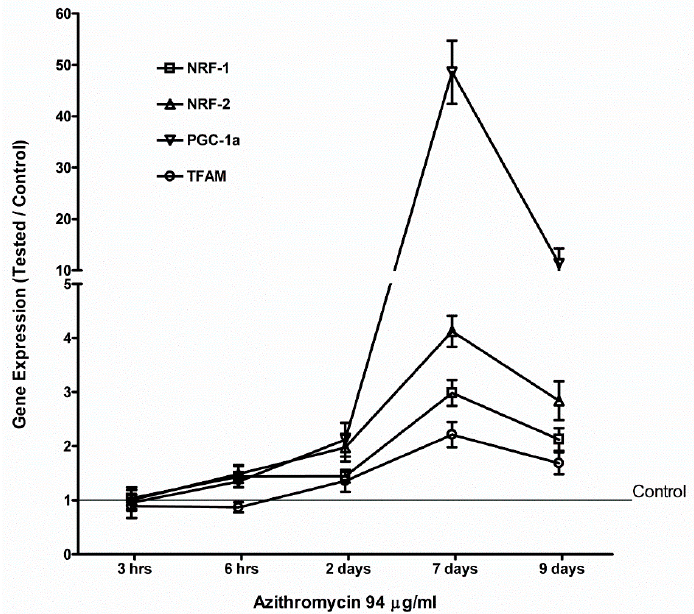
Figure 5. Azithromycin increased gene expression of mitochondrial biogenesis factors in MCF-12A cells. NRF-1 : nuclear respiratory factor 1; NRF-2 : nuclear respiratory factor; PGC-1a : peroxisome proliferator- activated receptor-gamma coactivator 1 alpha; TFAM : mitochondrial transcription factor A.